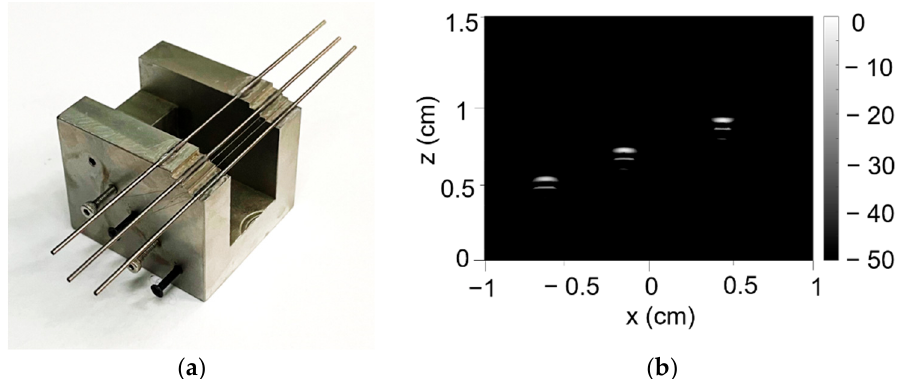
Figure 11. ( a ) Tungsten rods phantom; ( b ) image of tungsten rods phantom.